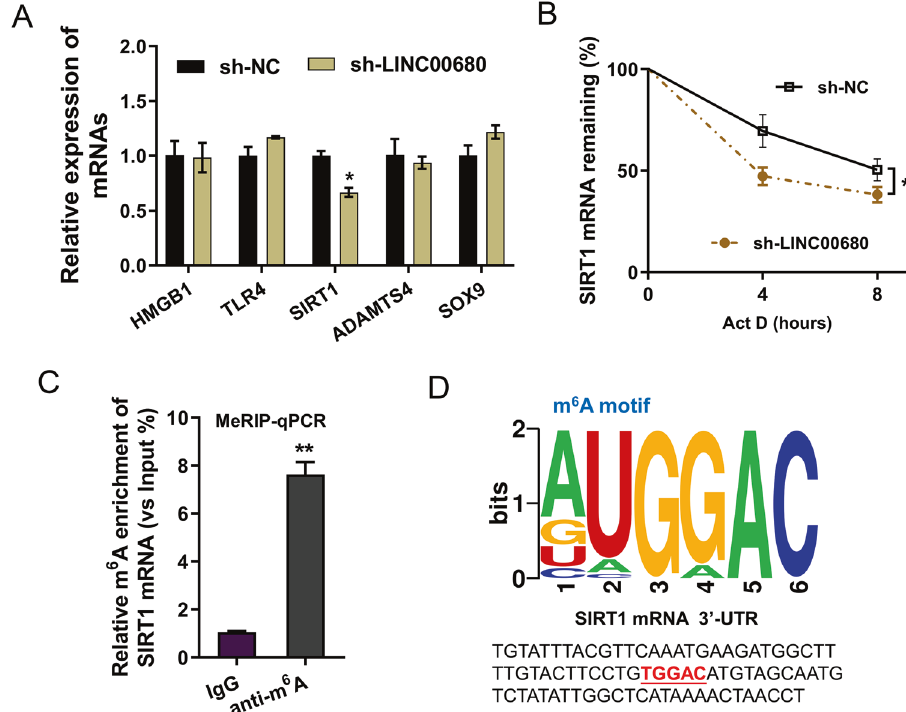
Fig. 4 LINC00680 positively regulated the stability of SIRT1 mRNA. A RT-PCR detected the levels of candidate mRNAs upon LINC00680 knockdown (sh-LINC00680). B RNA stability analysis revealed the SIRT1 mRNA stability in chondrocytes when administrated with Act D (2 mg/ mL)), including LINC00680 knockdown and control. C MeRIP-qPCR assay followed by qRT-PCR revealed the SIRT1 mRNA m 6 A modi fi cation. D Online predictive tools (RMBase, http://rna.sysu.edu.cn/rmbase/) revealed that the m 6 A motif in the 3 ’ -UTR of SIRT1 mRNA. Experiments